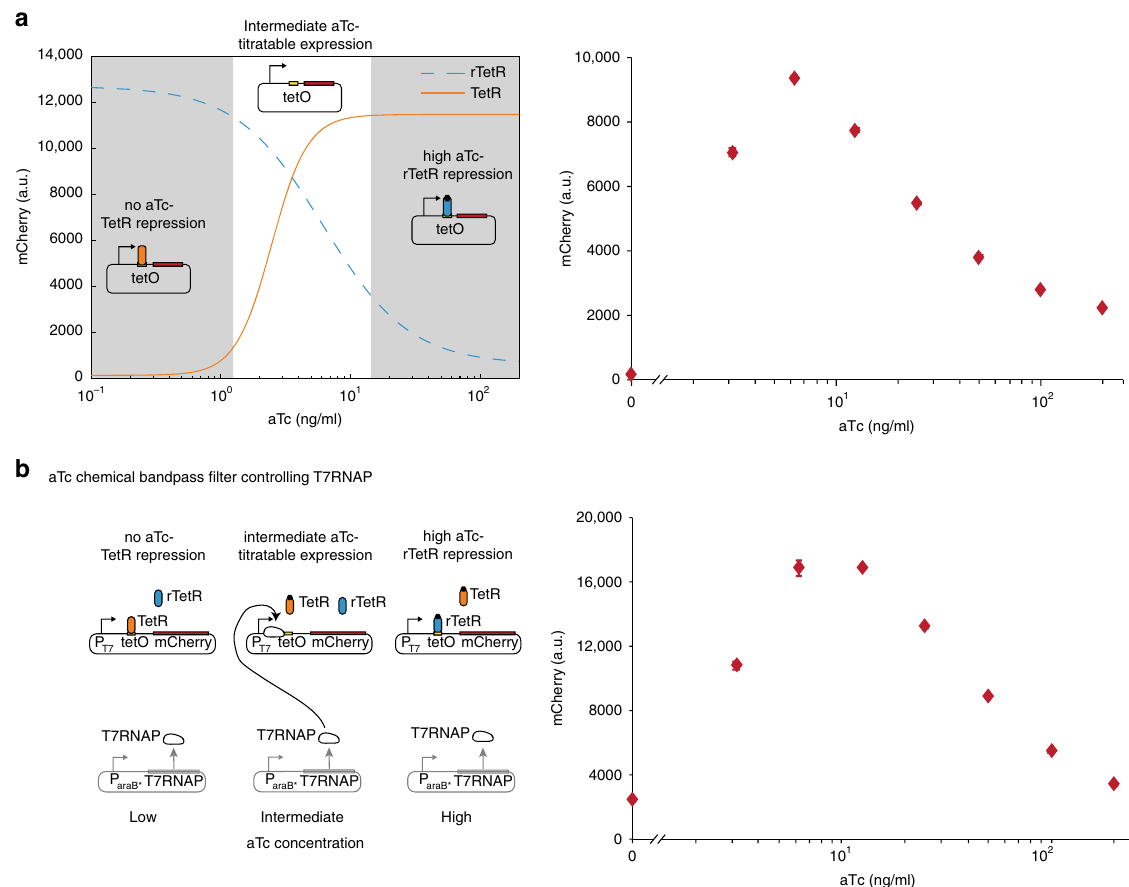
Fig. 4 aTc concentration bandpass fi lter. a Left, combining TetR (orange line) and rTetR (blue dashed line) in the same cell enables activation of aTc-induced expression due to the difference in effective inducer concentration. No aTc causes TetR repression and intermediate aTc concentrations (~10 – 200 ng/ml) enable titratable mCherry expression ( a right). b aTc bandpass fi lter controlling the T7RNAP expression system. Expanding the topology of a , mCherry expression through T7RNAP R632S W727C is controlled by the bandpass fi lter ( b left). Again, no aTc causes TetR repression and intermediate aTc concentrations (~10 – 200 ng/ml) enable titratable mCherry expression via the T7RNAP ( b right). Diagrams show mean mCherry expression values and standard deviation of three biological replicates ( n = 3) measured after 5 h incubation time in all cases. Source data are provided as a Source data fi